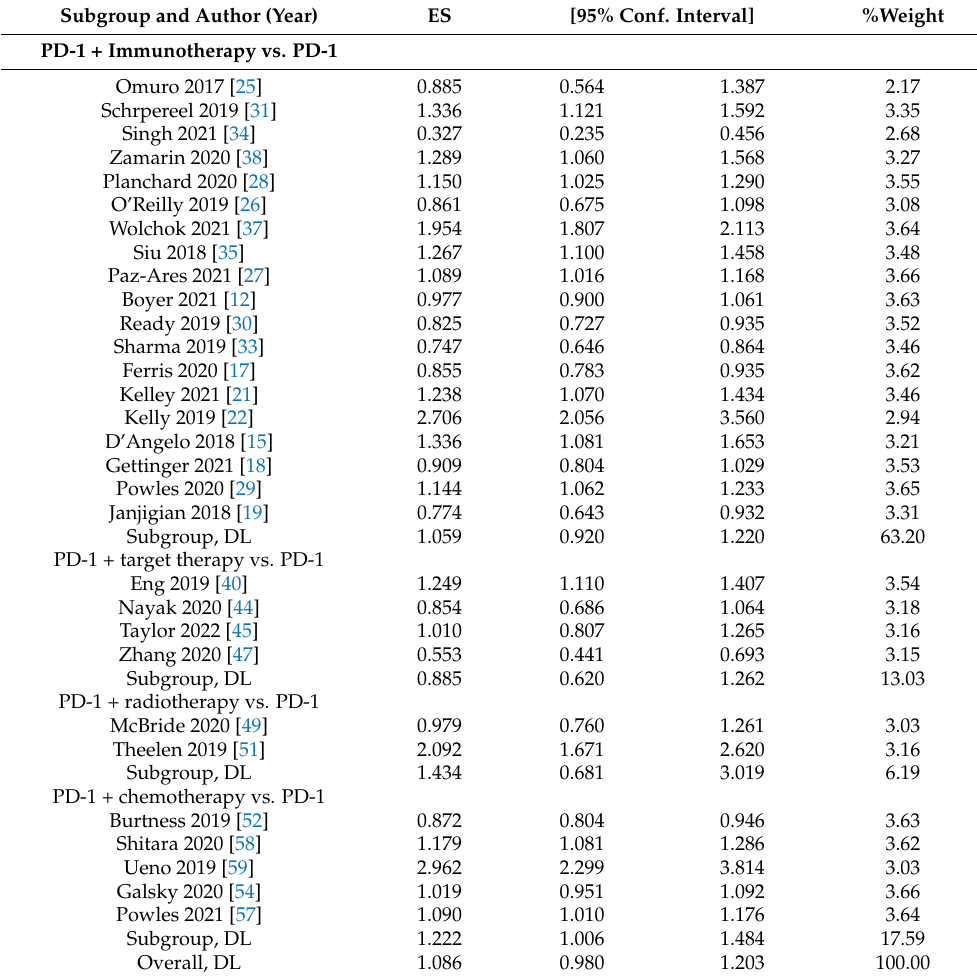
Table 2. Median survival ratio of OS based on therapeutic